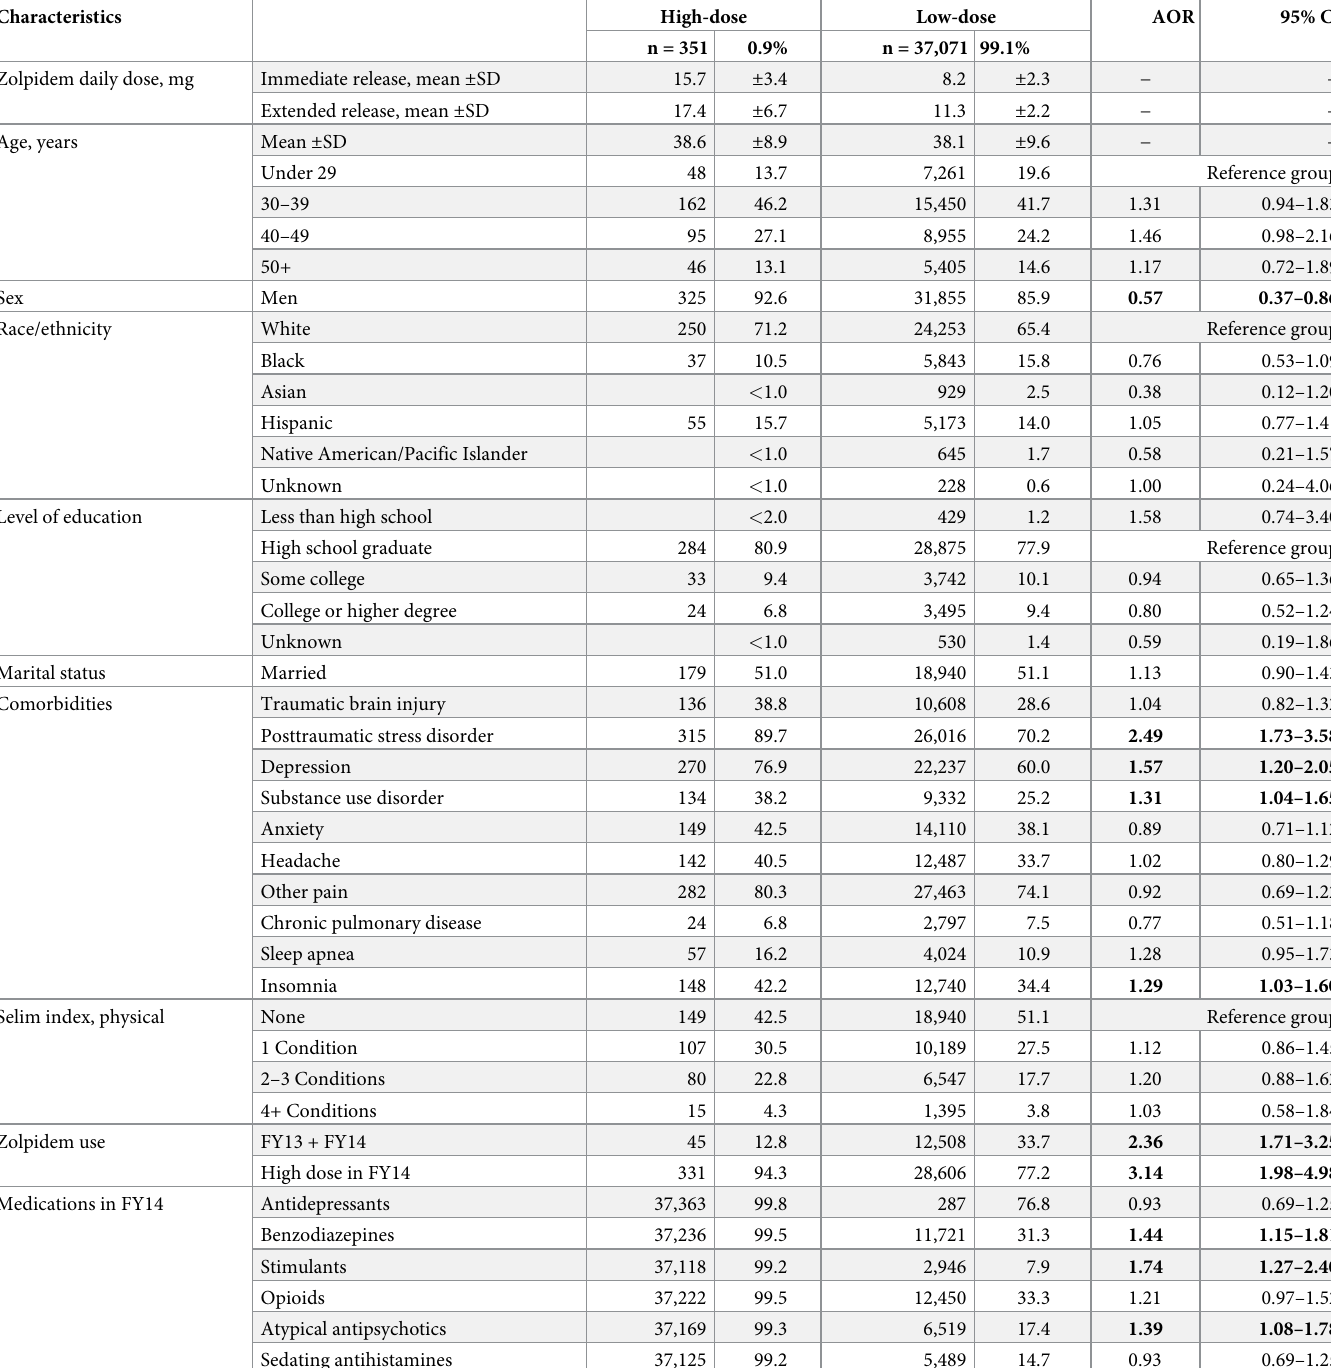
Table 3. Adjusted odds ratios (AOR) of correlates of high-dose zolpidem use among Iraq and Afghanistan veterans in fiscal year 2014.